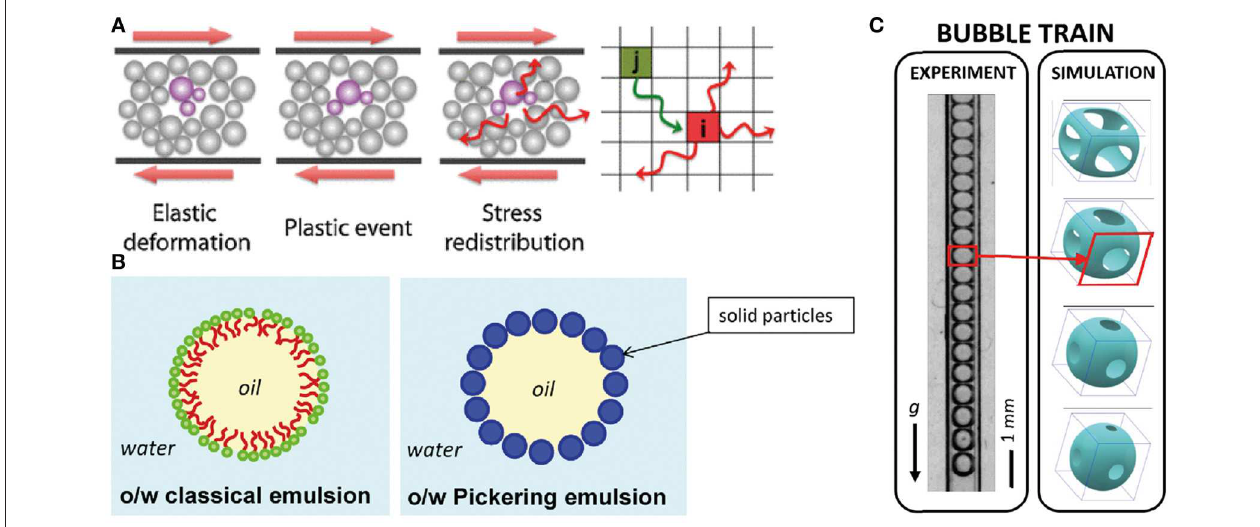
FIGURE 1 | (A) The canonical kinetic elasto-plastic perspective in which induced flow generates non-local structural changes. From Bocquet et al. [48]. (B) Schematic of surfactant and particle stabilized oil in water (o/w) emulsions. From Chevalier and Bolzinger [ 53]. (C) Evidence for multiple contact dynamics in a simple train of bubbles. From Ginot et al.